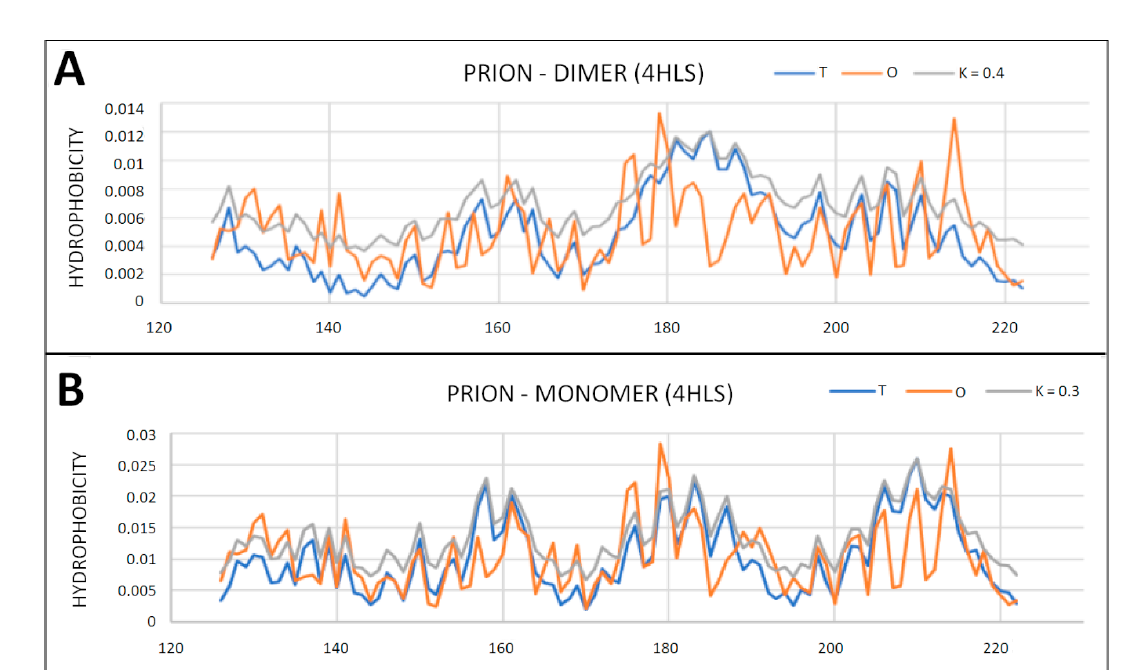
Figure 8. T, O and M profiles for the prion protein for which its structure available in PDB is dimer—4HLS. ( A ) Profiles for the chain A as it shows in dimer; ( B ) profiles for a monomer treated as an individual structural unit.